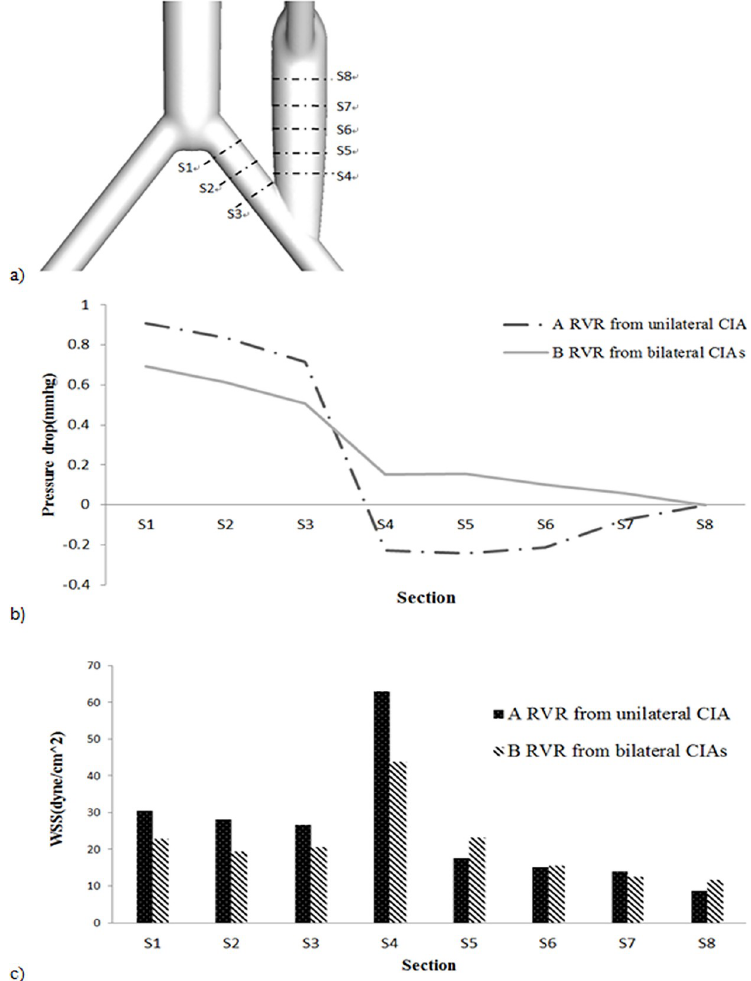
Fig 8. To have a better view of the effect of graft type on the hemodynamic parameters, 8 slices of the configurations were chosen for the calculation of the area-averaged WSS and pressure drop. a) the sketch of the 8 slices. b) the area-averaged pressure drop. c) area-averaged